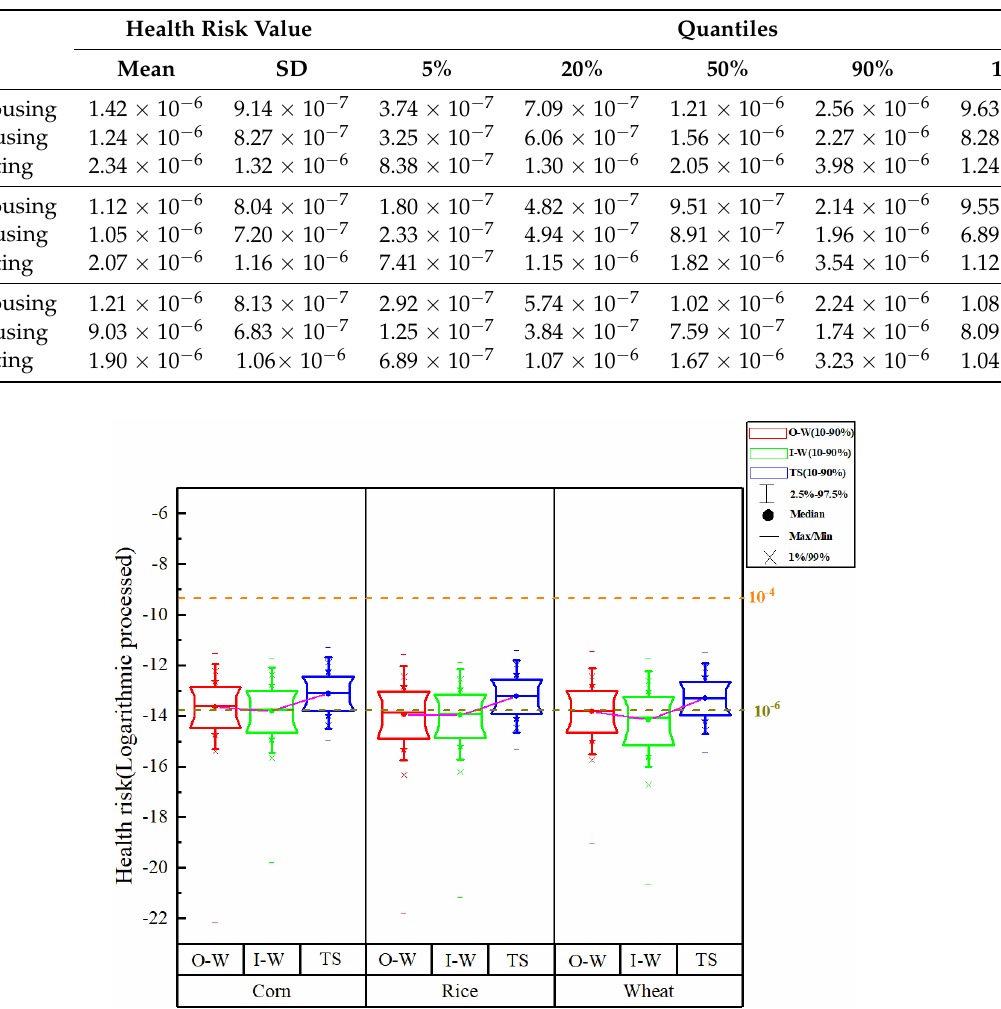
Table 5. Statistical values of health risk in different stages of each grain.